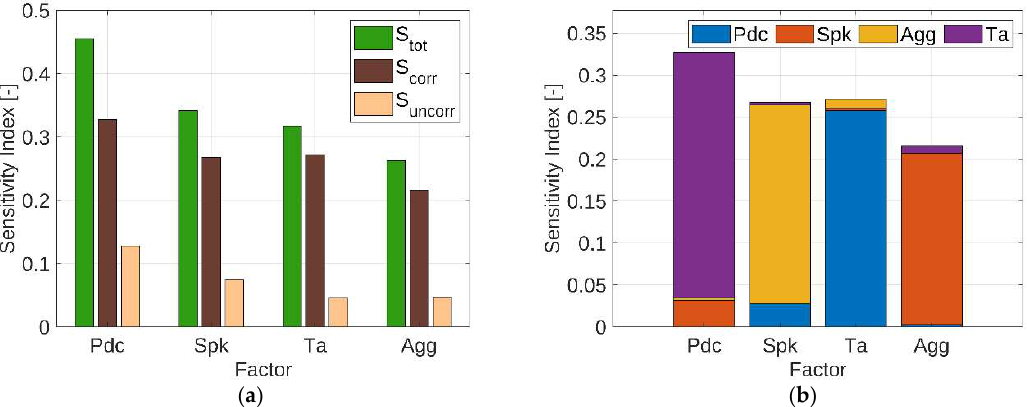
Figure 17. Sensitivity indices of the crucial operation factors affecting the variation in ECR. ( a ) The partial variance decomposition is on the left, and ( b ) the normalized second-order effects are on the right.